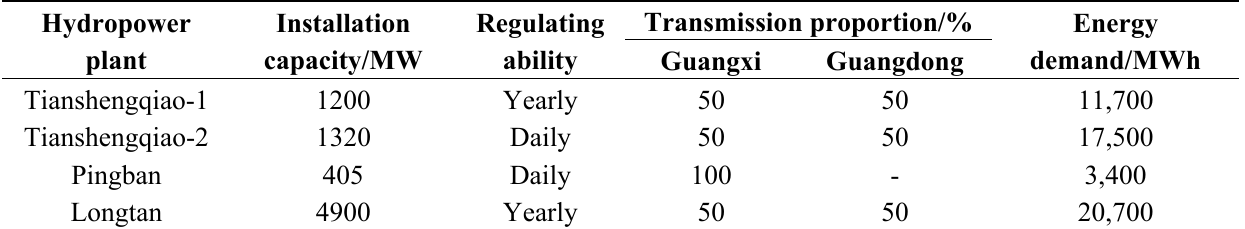
Table 3. Detailed characteristics for cascaded hydropower plants on Hongshui River.